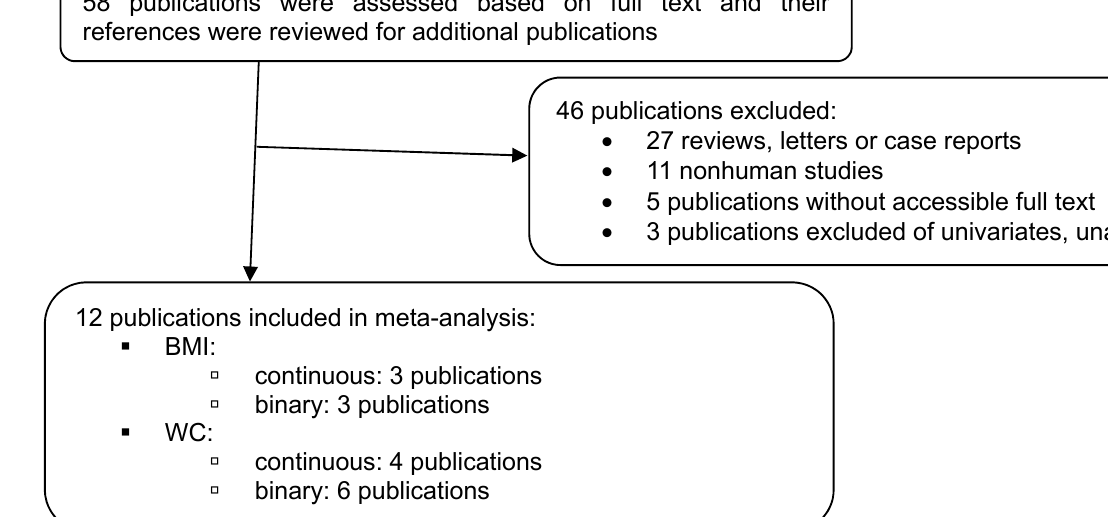
Figure 1. Flowchart for study